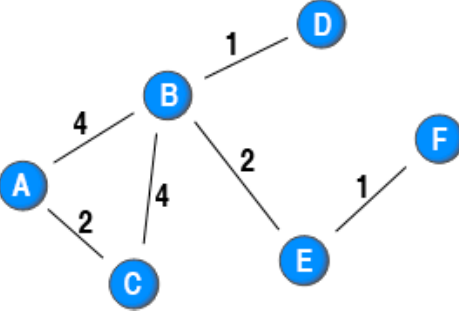
Figure 3. Weighted network graph.